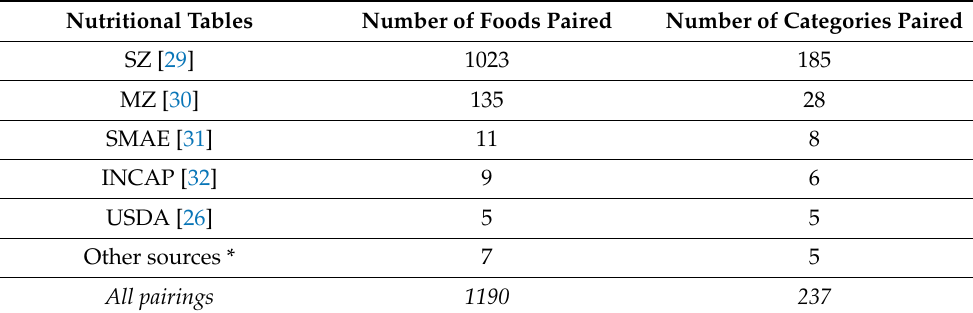
Table 1. Nutritional tables consulted and number of food pairings. Nutritional